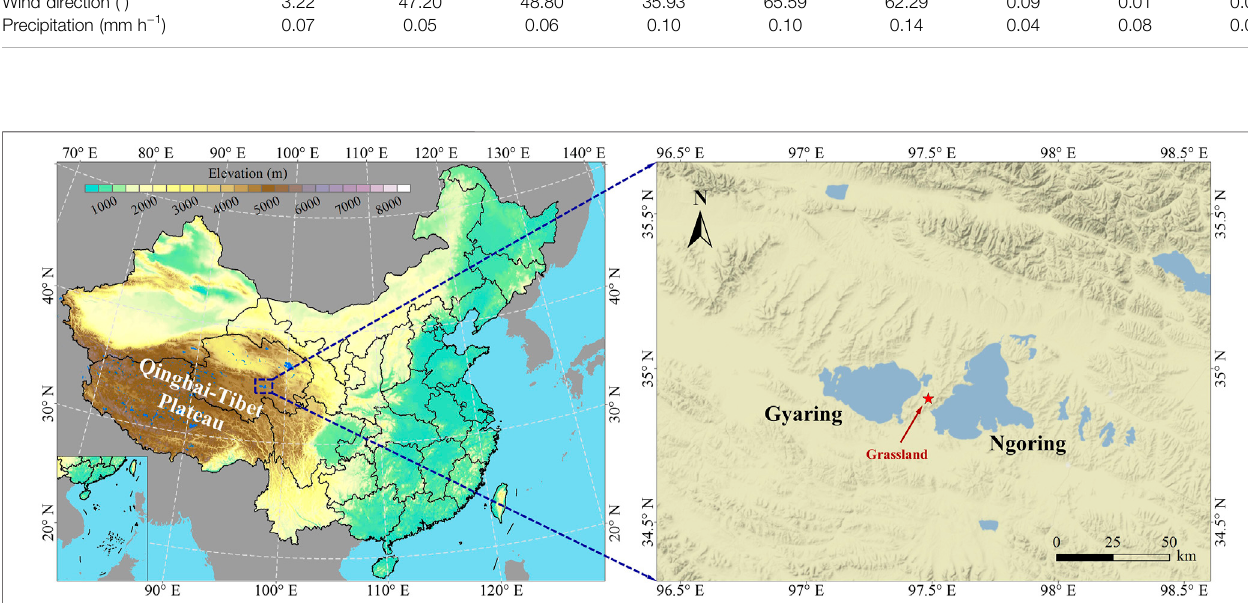
Frontiers in Earth Science |